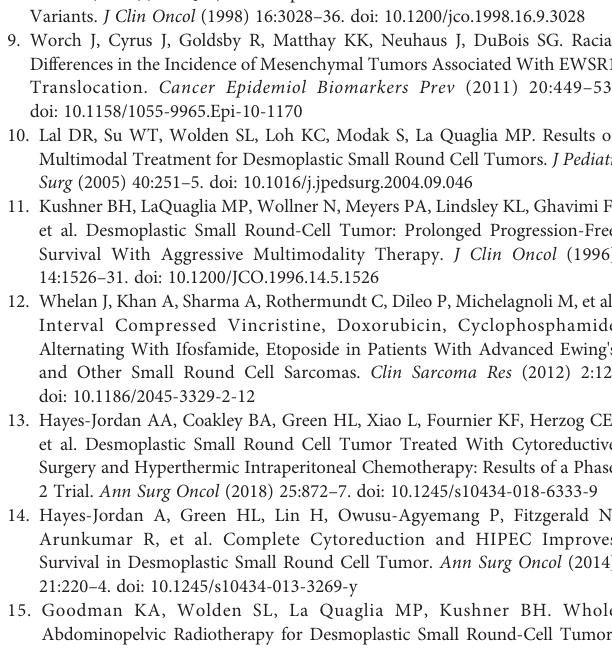
clinical attributes (NCT04690374) and immune